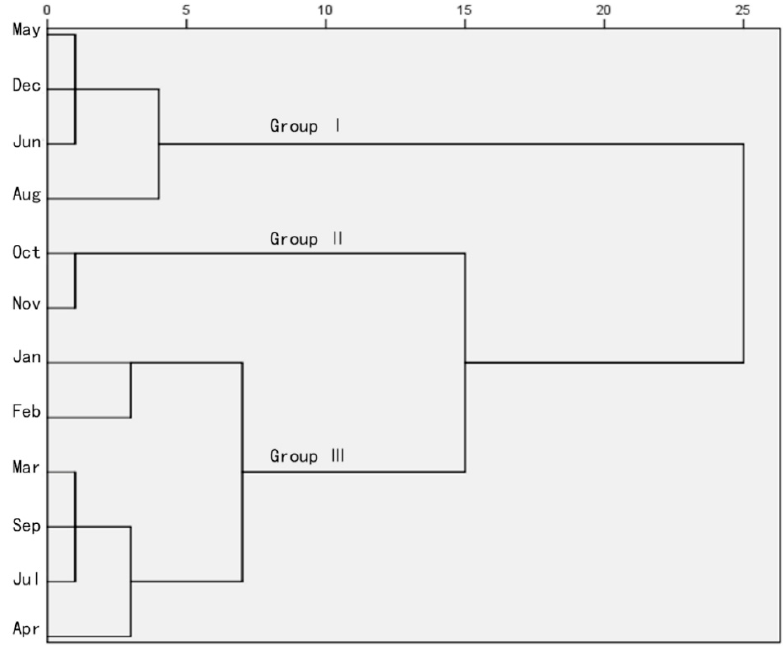
Figure 3. Cluster analysis diagram based on ingredient contents and bioactivities.